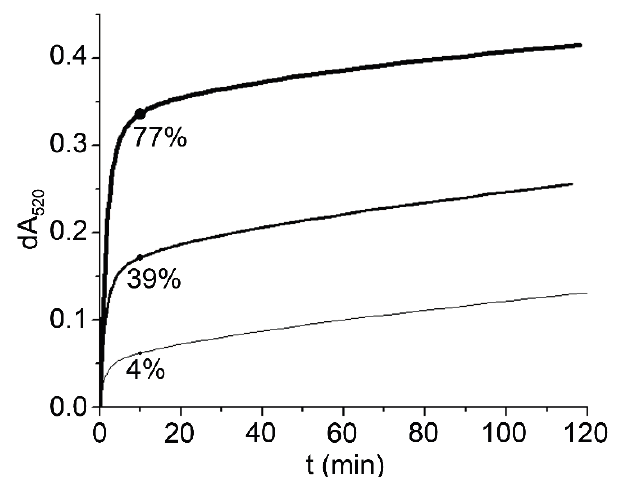
Figure 2. Reactivity of linseed oil (thick line, c tocopherols = 1.12 mmol/kg), peroxidized linseed oil (intermediate line, c tocopherols = 0.30 mmol/kg) and linseed oil stripped of tocopherols (thin line, c tocopherols = 0.01 mmol/kg) in a DPPH assay performed in 2-propanol. The contribution of tocopherols to AOP is shown in